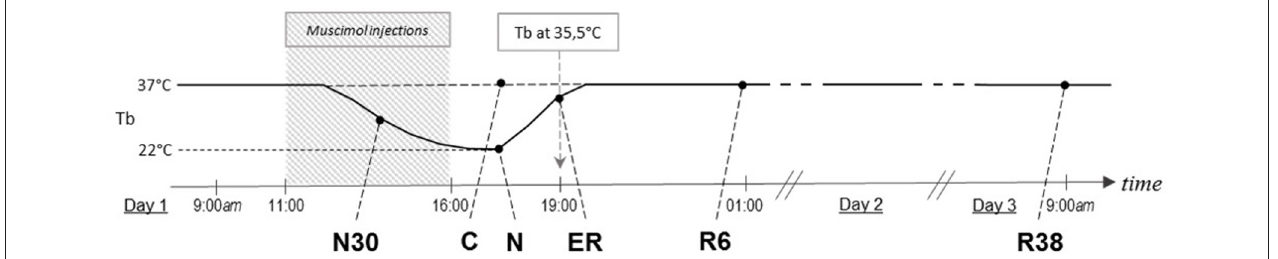
FIGURE 1 | Schematic representation of how the experimental conditions were defined. The solid line indicates the progress of brain temperature (Tb) throughout the experiment. The dotted line refers to the control group (C). The shaded area represents the period when synthetic torpor (ST) was induced. N30, samples taken when Tb reached 30 ◦ C; N, samples taken at nadir of hypothermia, during ST; ER, early recovery, samples taken when Tb reached 35.5 ◦ C following ST; R6, samples taken 6h after ER; R38, samples taken 38h after ER.